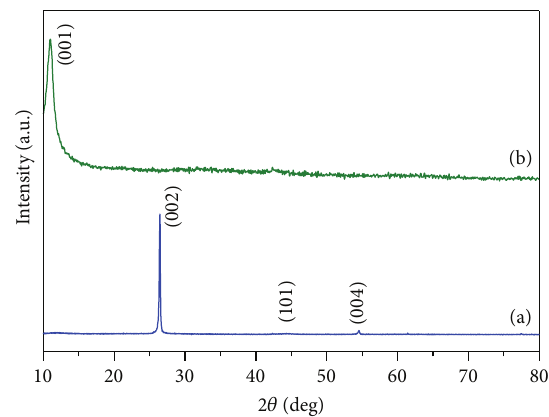
Figure 1: XRD pattern for (a) raw graphite and (b) graphite oxide.